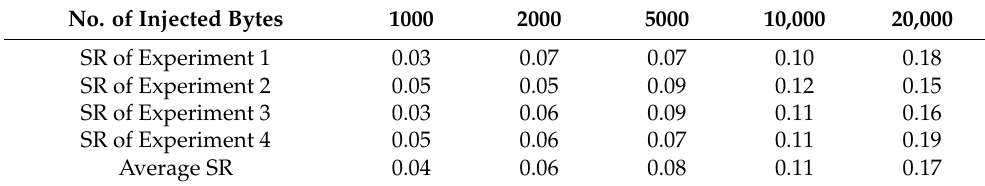
Table 5. SR of the randomly injecting method adopting end-of-file strategy.